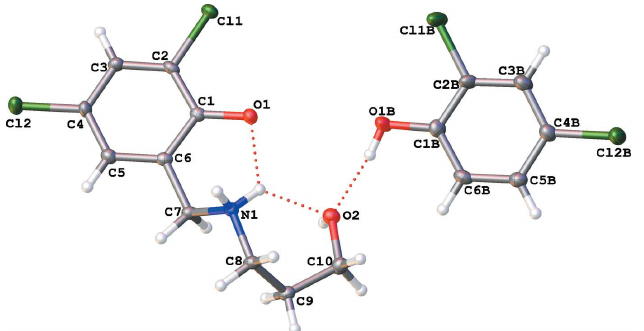
Figure 2 Molecular structure of the zwitterionic part of the co-crystal depicting the selected hydrogen-bonding graph sets. H atoms not involved in hydrogen bonding have been omitted for clarity and hydrogen bonds are drawn with red dashed lines.